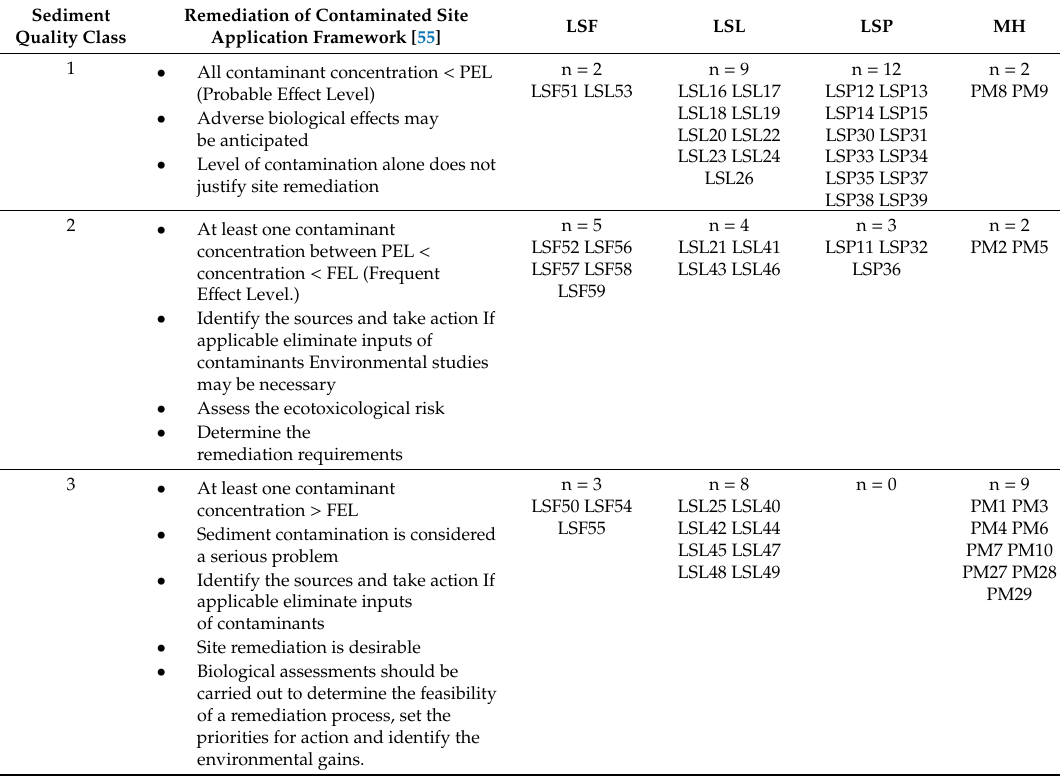
Table 1. Application of the sediment remediation framework and number of sites for each sediment quality class in the habitat zones (Lake Saint-François (LSF), Lake Saint-Louis (LSL), Lake Saint-Pierre (LSP) and Montr é al Harbour